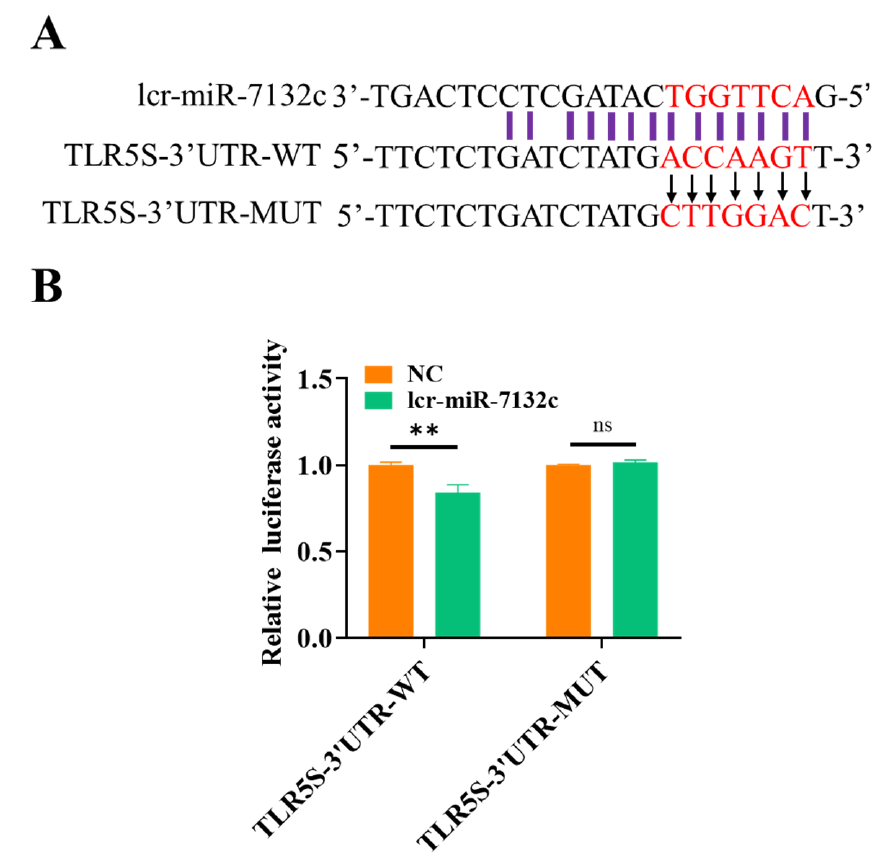
Figure 6. In vitro verification of the interaction between DEmiRNA lcr-miR-7132c and DEmRNA TLR5. ( A ) Schematic showing the binding between lcr-miR-7132c and the wild-type sequence carried by the control reporter plasmid (TLR5S-3 ′ UTR-WT), as well as the sequence carried by the mutated reporter plasmid (TLR5S-3 ′ UTR-MUT). ( B ) Luciferase activity in HEK293T cells 24 h after co-transfection with TLR5S-3 ′ UTR-WT or TLR5S-3 ′ UTR-MUT and the lcr-miR-7132c mimic or the negative control mimic (NC mimic). Luciferase activity was normalized against Renilla luciferase activity. Error bars represent the SEM of three independent assays. ** p < 0.01; ns, not significant. Three DEmRNAs ( B3GNT5A , TLR5S , and DNMBP ) and three DEmiRNAs (dre-miR- 199-3p, lcr-miR-7132c, and lcr-miR-N201) were randomly selected for RT-qPCR validation. The expression patterns were similar across the two types of analyses: B3GNT5A , lcr-miR- 7132c, and lcr-miR-N201 were downregulated in both the RNA-seq/sRNA-seq data and the RT-qPCR results, while TLR5S , DNMBP , and dre-miR-199-3p were upregulated in both the RNA-seq/sRNA-seq data and the RT-qPCR results (Figure